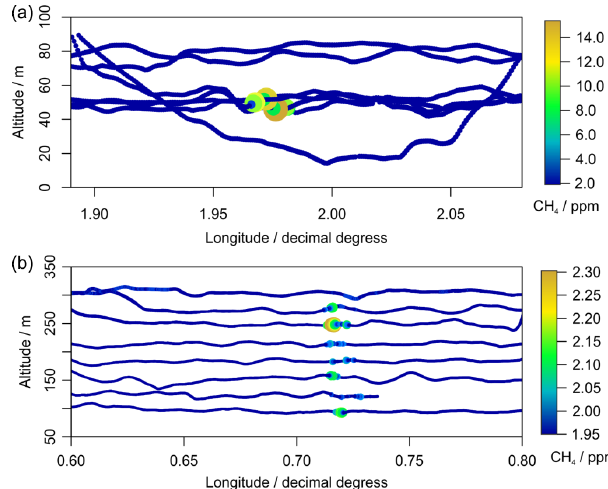
Figure 7. Plumes measured from separate installations to demon- strate the differences in strategies between 2018 and 2019. (a) Plume sampled downwind with poorer vertical spatial resolu- tion in the 2D plane during the 2018 portion of the campaign. CH 4 measured values are much higher due to platform activities during the survey time. (b) Plume sampled downwind in 2019 with inter- mediate transects enabling higher vertical spatial resolution. Note that the colour scale across each plot signifies different measured CH 4 ; the scales on the upper and lower plots are different.